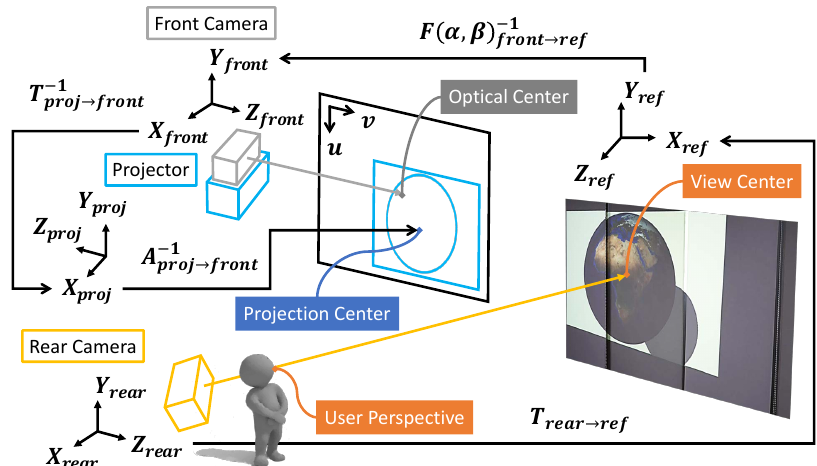
Figure 5. The illustration to describe and accompany Equation (3) and Figure 4. The user’s perspective is tracked by the rear camera and ray-casted to determine its view center on the surface in the reference coordinate. The view center coordinate is sequentially transformed to the front camera and the projector coordinate. Finally, the coordinate is projected onto the image domain of the projector to determine the corresponding point in the projection texture.